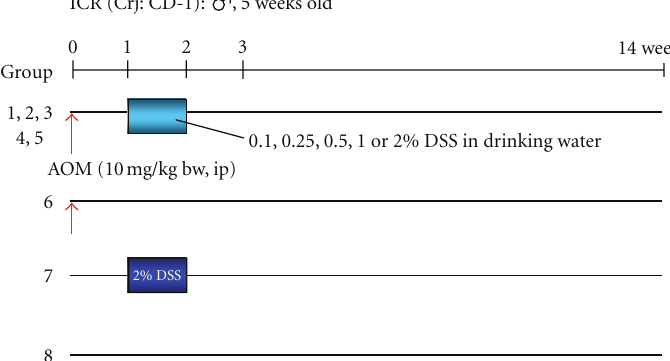
Figure 7: Experimental protocol for determining dose-response of DSS in mice initiated with AOM [21].